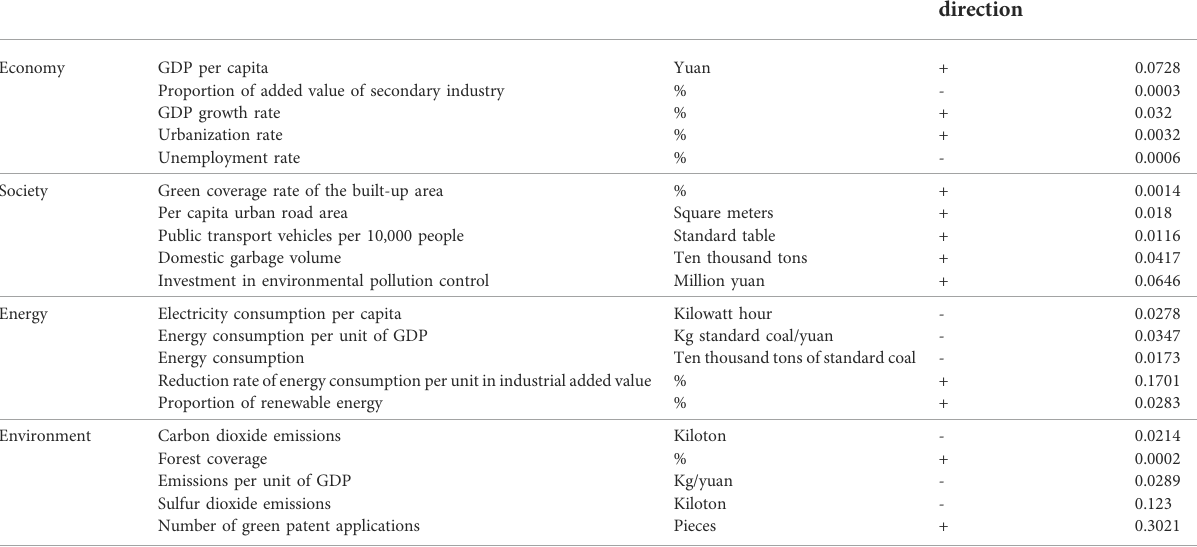
TABLE 1 Evaluation system of low-carbon development level in Fujian